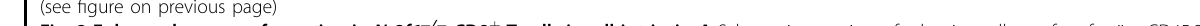
OT-I Nr2f6 + / + or Nr2f6 − / − cells into a congenic (CD45.1 + or CD45.1 + CD45.2 + ) host, with LmOVA infection the day after and harvest on d7. One day after cell transfer the mice were infected with LmOVA. The analysis was performed 7 days post cell transfer. B Representative plots, quanti fi cation of frequencies and total cell numbers per spleen of SLECs (CD127 − KLRG1 + ) and MPECs (CD127 + KLRG1 − ) OT-I T cells at d7 after infection. Gated on CD45.2 + CD45.1 − CD8 + CD44 + . C Representative histogram of KLRG1 expression and MFI of KLRG1. D Representative dot plot and frequency of CXCR3 in Nr2f6 + / + or Nr2f6 − / − OT-I T cells. MFI out of CXCR3 + cells (positive cells from the dot plot) is shown, with a representative histogram. E Representative plots and frequency of CD122 + CD127 + OT-I T cells. Gating is based on FMO controls. F Representative plots of cytokine production by transferred OT-I T-cells from spleen after recall ex vivo with N4 peptide, d7 post-LmOVA infection. G Frequencies of SLECs (CD127 − KLRG1 + ) and MPECs (CD127 + KLRG1 − ) OT-I T cells in the blood over time at indicated days after infection. H Ratio of OT-I over host CD8 + T cells in blood over time, at indicated days after infection. Representative data are shown from one independent, out of at least two replicative experiments, with n = 3 ( B – F ) per group and experiment. G , H Data are shown as pooled experiments of at least two independent experiments n = 3 – 7. Each dot represents the data of an individual mouse. Results are shown as mean ± SD. An asterisk indicates statistically signi fi cant differences between genotypes calculated using Student ’ s t test or mixed-effects model (REML) ( G , H ). A p value < 0.05 was considered statistically signi fi cant. * p < 0.05; ** p < 0.01; ns not signi fi cant. All OT-I T cells are gated as CD45.2 + CD45.1 − CD8 + CD44 +